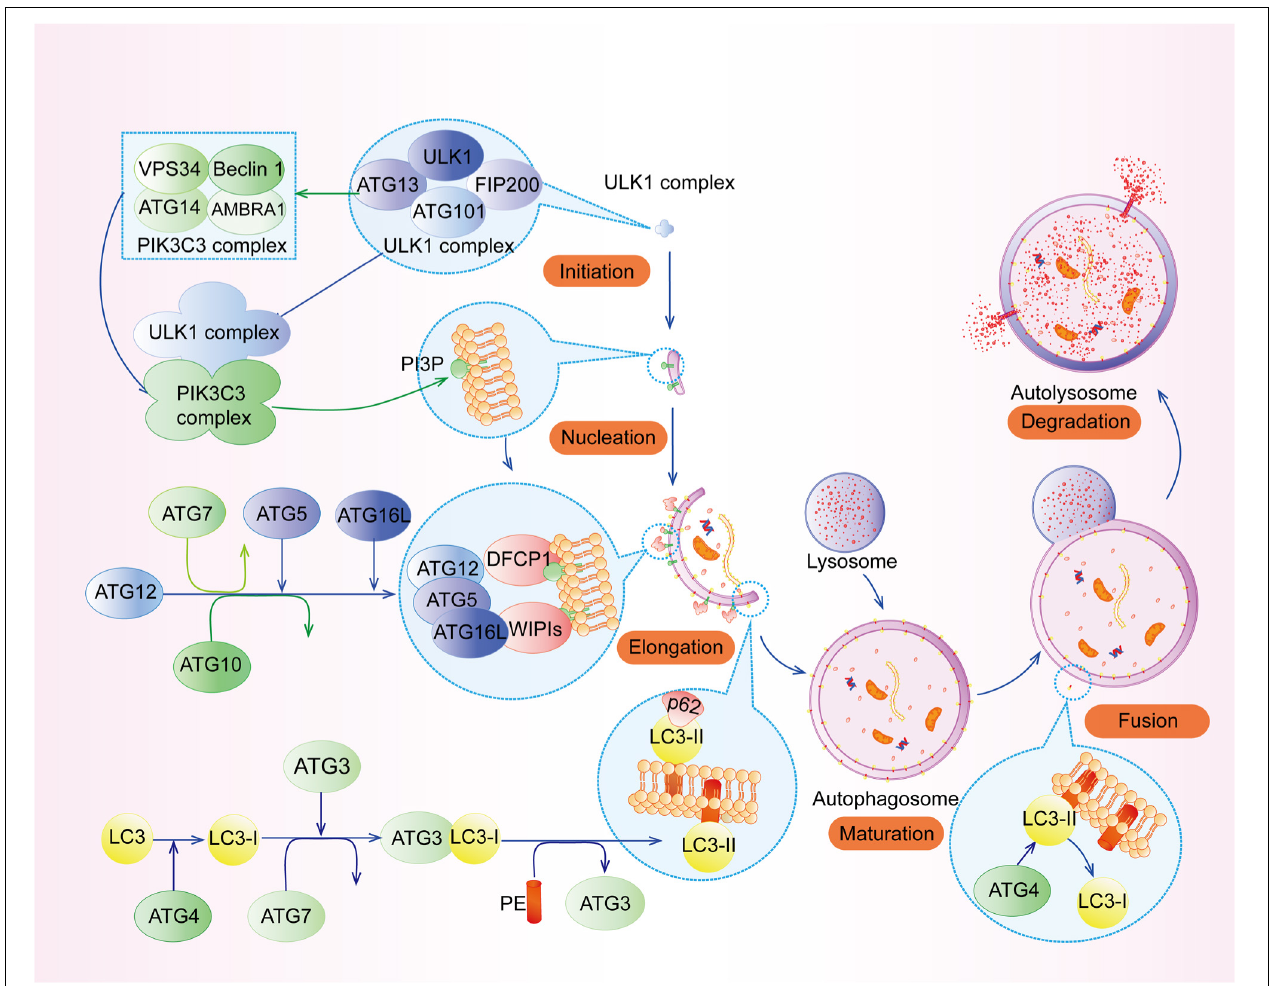
FIGURE 1 | The process of autophagy. The process of autophagy can be divided into the following stages: (1) initiation, (2) vesicle nucleation, (3) vesicle elongation and maturation, (4) vesicle fusion, and (5) cargo